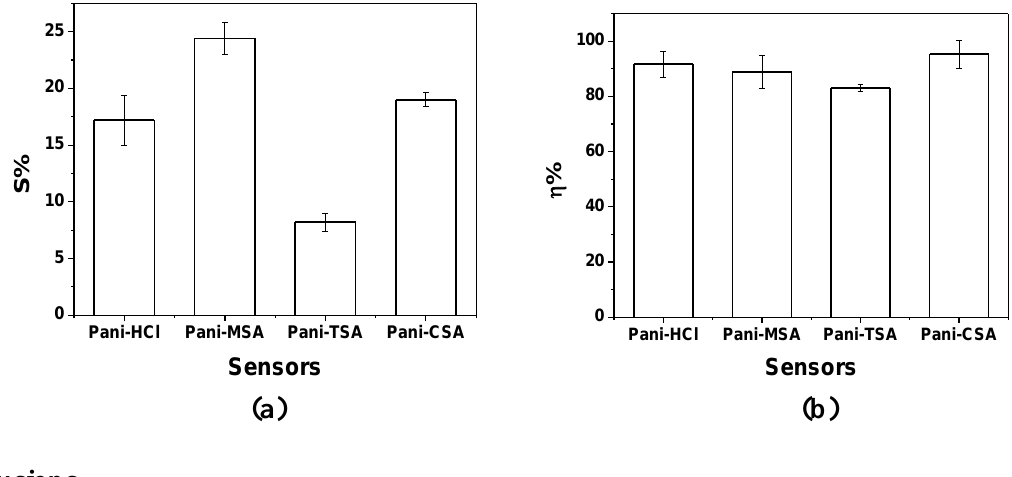
Figure 6. (a) Sensitivity (%) and (b) reversibility (%) of sensors based on thin film PANI-ES prepared by in-situ polymerization and doped by anion replacement with various acids, on exposure to dry nitrogen flow; (Ι) standard deviation of three